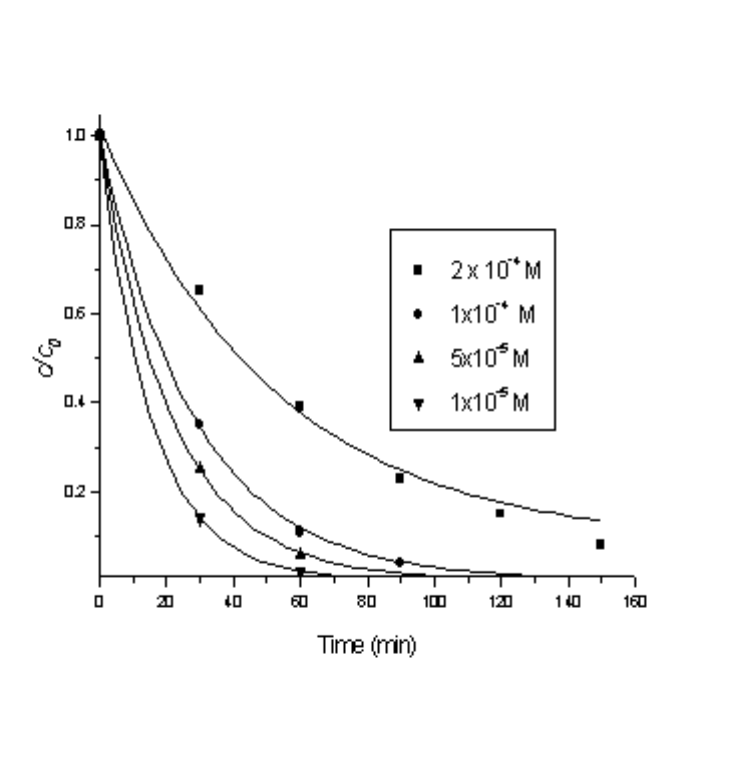
Fig. 2 Plasma degradation at different concentrations.